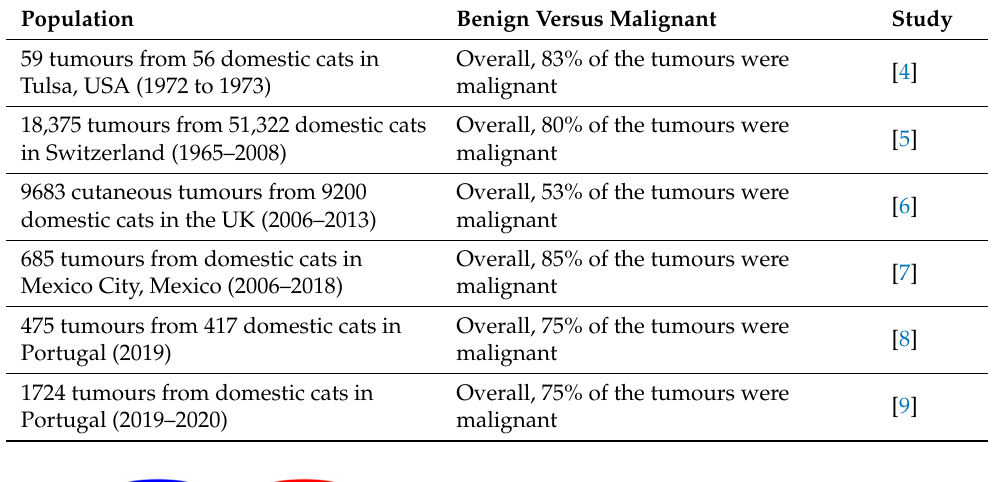
Table 1. A summary of studies looking at the type of tumours most commonly found in domestic feline populations and their relative severity of the tumour.